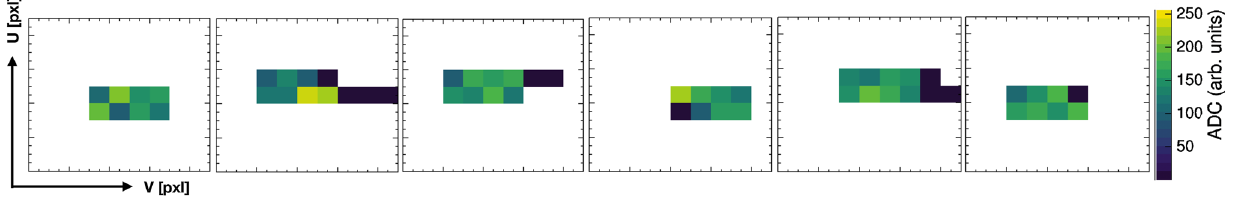
Fig. 15 Example beam-background matrices with a low MLP and a comparably high AE classification score